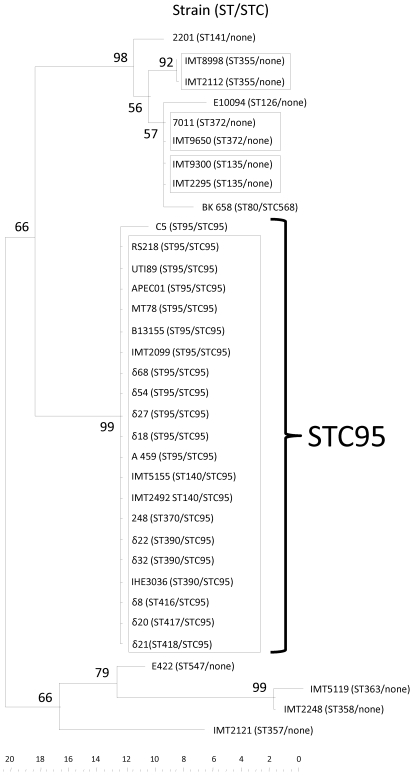
Maximum Parsimony tree constructed from ibeA sequence data (identical ibeA sequences are indicated by boxes).